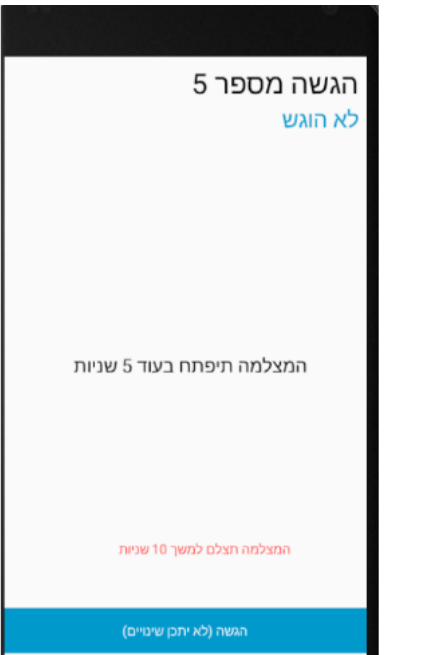
Figure 17. Photo panel screen for the patient: After a 10-second countdown, photographs are taken.